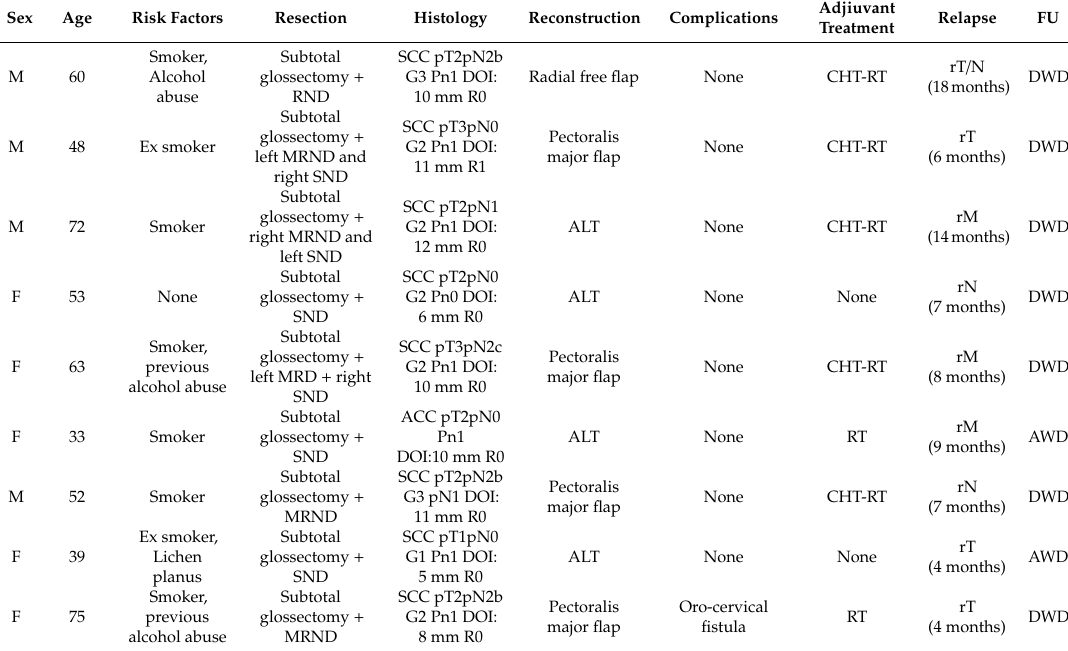
Table 2. Details of cases in which recurrence was